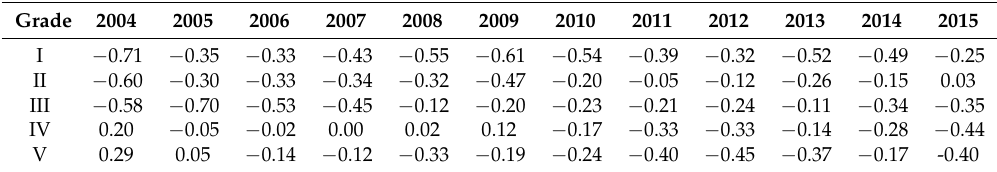
Table 7. Comprehensive degree of connection determined by additive weighted synthesis.